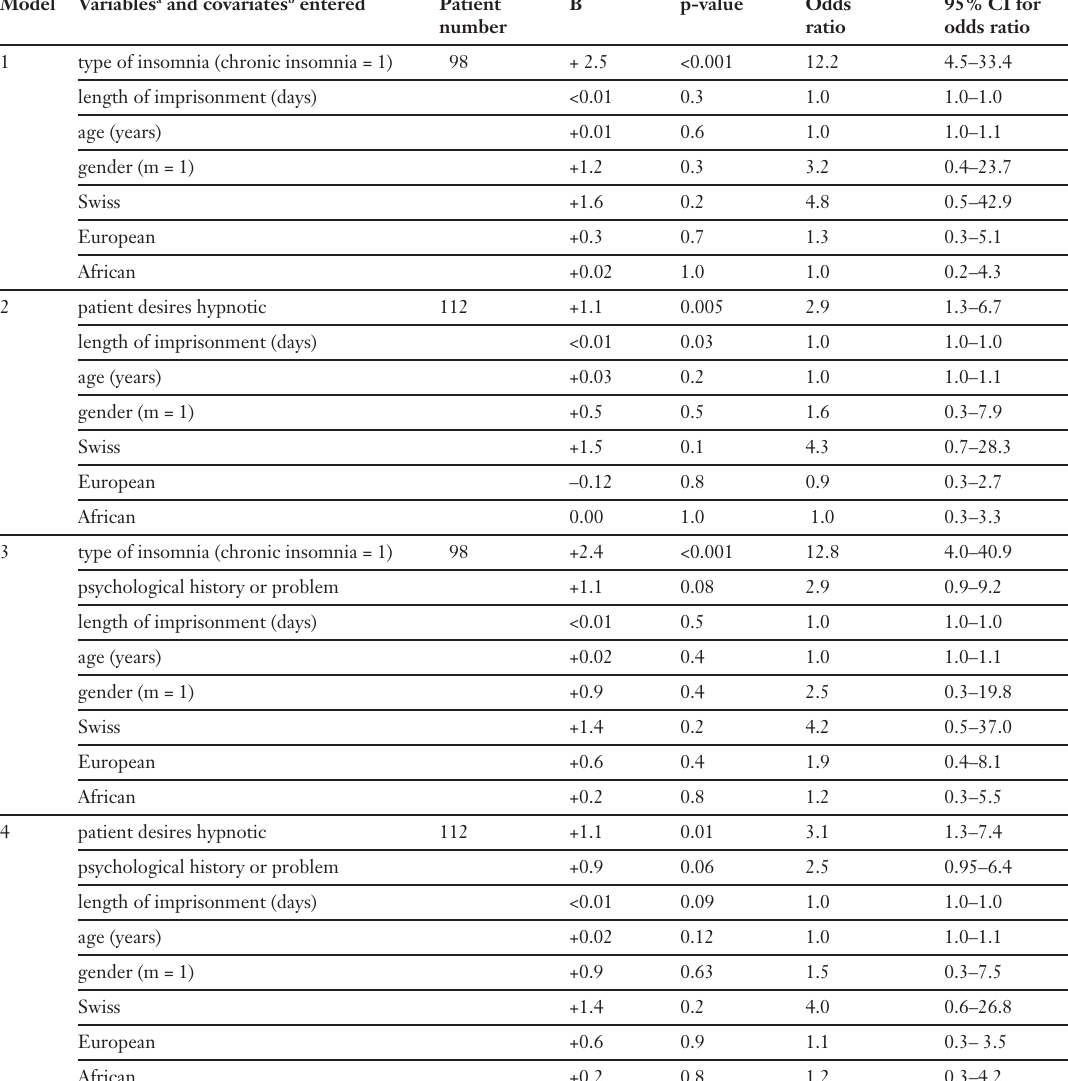
Binary logistic regression of the dependent variable: treated with benzo- diazepines (n = 66) vs. not treated with benzodiazepines (n =